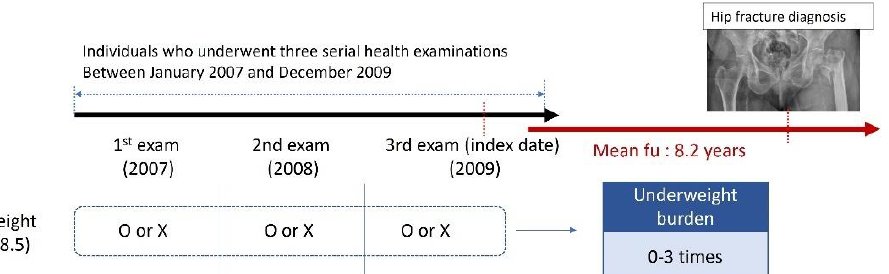
Figure 2. Overall plan of the study. Evaluation of the cumulative underweight burden (0 – 3 records) at three consecutive health examinations (between 2007 and 2009) by incidence of hip fracture during a mean follow-up of 8.2 years.